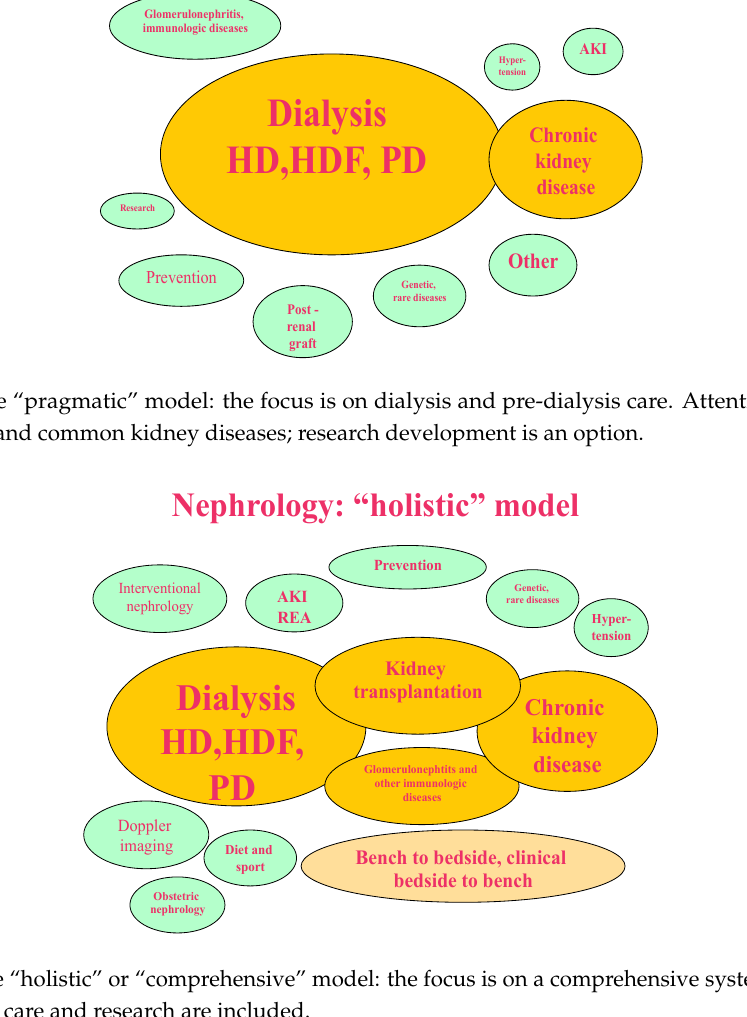
Figure 4. The “ideal-utopic” model: the focus is on prevention, that should decrease the need for chronic kidney disease (CKD) care and for renal replacement therapy. Research is highly developed, both ways, bench to bedside and bedside to bench. The aim of our analysis of these approaches is to enable us to reflect on the organizational aspects of nephrology, a discipline that, despite the great improvements that have been made and its enormous potential, fails to fully respond to patients’ needs, as witnessed by the significant number of cases that yearly reach end-stage kidney disease (up to 40% in some European countries), in which chronic kidney diseases developed without the nephrology care that could have retarded dialysis start and perhaps prolonged life [27–30]. Defending or expanding the nephrology workforce is a choice that clashes with the current European trend to replace specialist care services with large medicine wards, which are considered